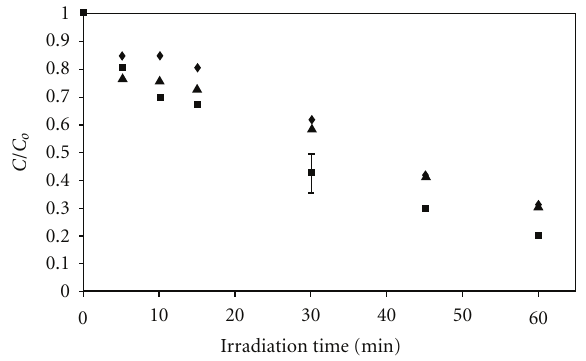
Figure 4: Comparison of abamectin degradation using the photo-Fenton process for: — (cid:4) — natural water; — (cid:2) — natural water (rainy day); — (cid:3) — distilled water. Conditions: [H 2 O 2 ] = 6.0mmolL − 1 ; [Fe 3+ ] = 0.5 mmolL − 1 ; abamectin = 9.0 mgL − 1 ; λ = 365nm; initial pH =